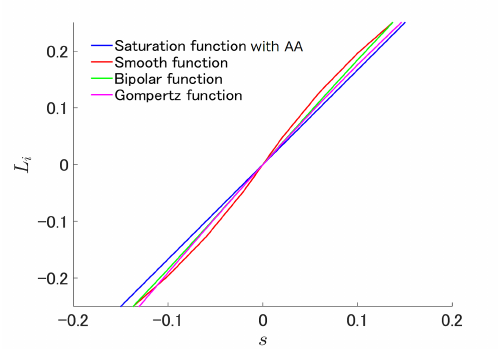
Figure 7. Candidate functions on dry asphalt simulation.